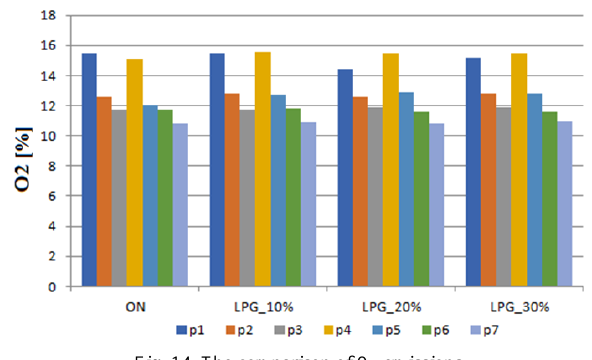
Fig. 14. The comparison of O 2